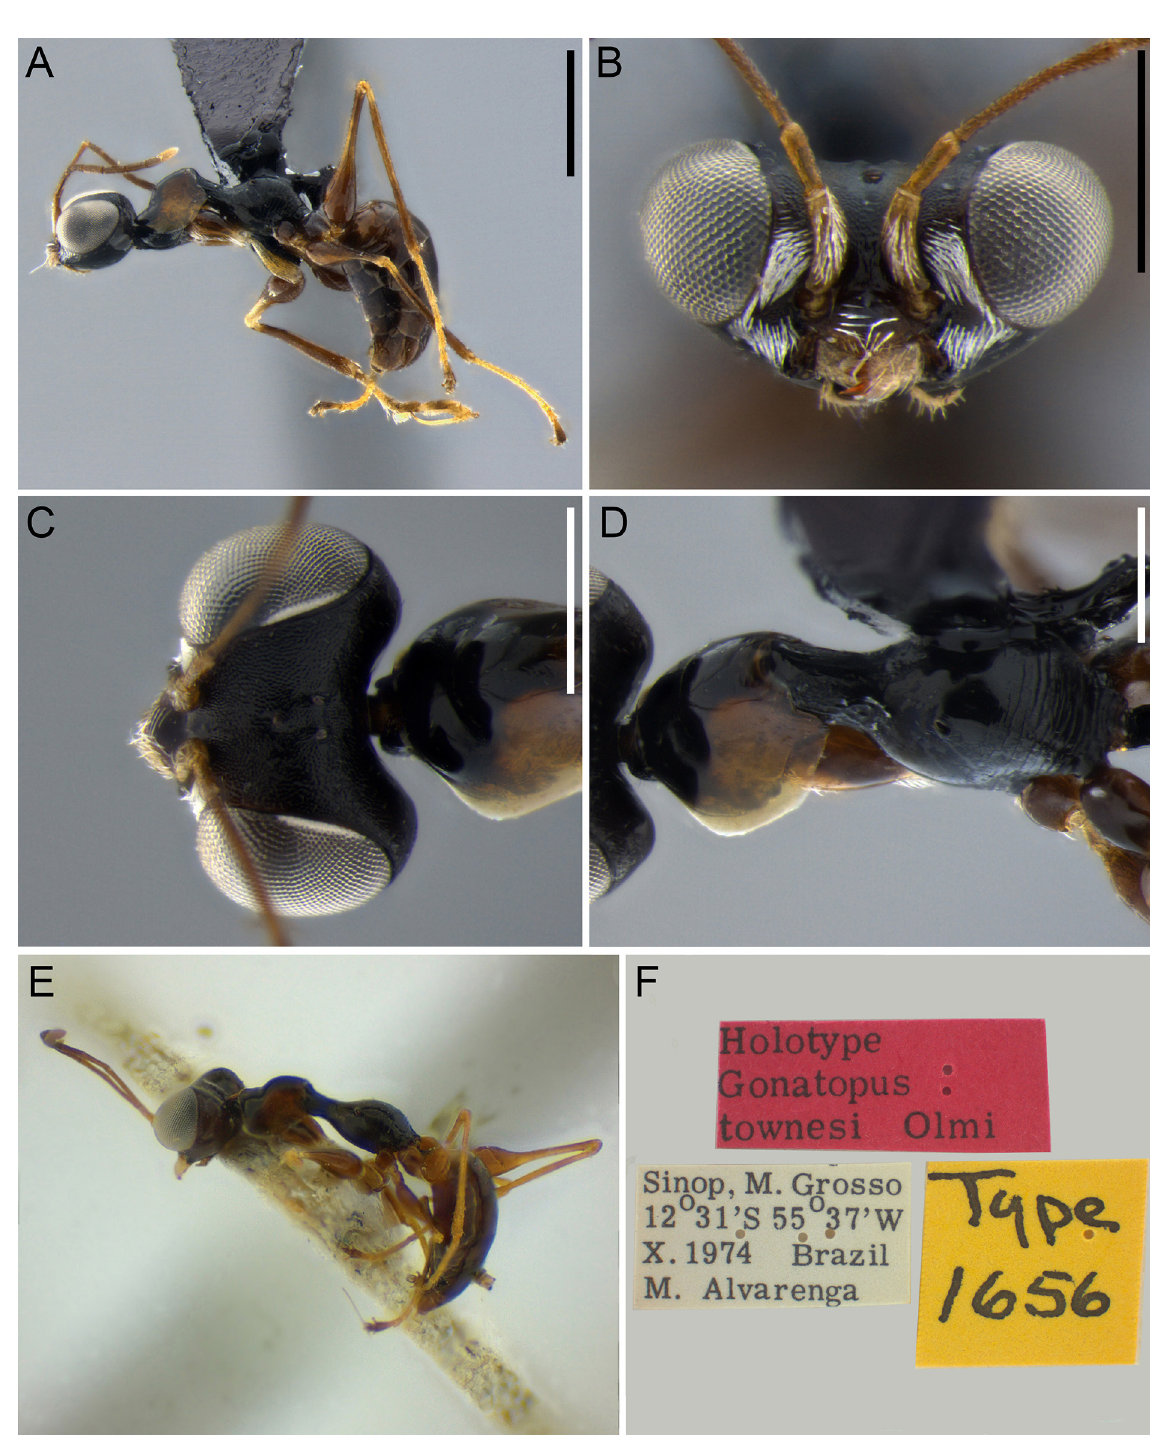
Fig. 7. Pareucamptonyx townesi (Olmi, 1984), ♀ A – D . Specimen from Distrito Federal. A . Habitus, lateral view. B . Head, frontal view. C . Head, dorsal view. D . Mesosoma, dorsal view. E – F . Holotype, ♀. E . Habitus of holotype, lateral view. F . Labels of holotype. Scale bars = 1.0 mm.